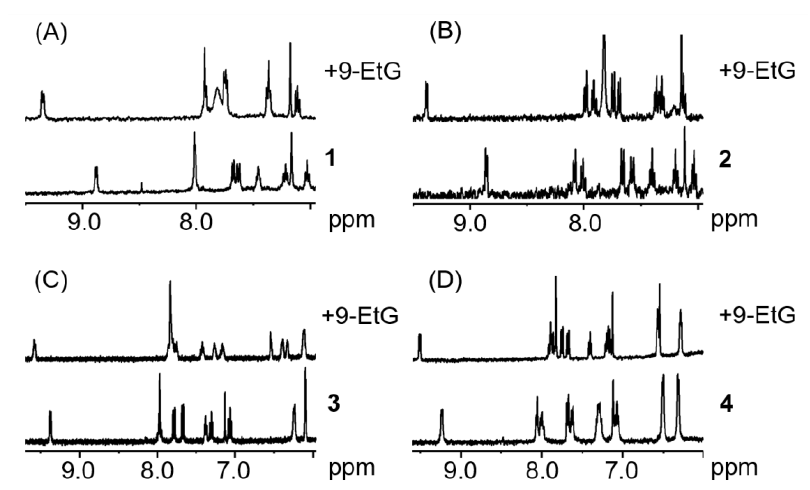
Figure 6. 1 H-NMR spectra of complexes 1 – 4 ( A – D , respectively) in the presence of two mol. equiv. of 9-EtG after less than 10 min (1.1 mM complex, MeOD / D 2 O 1:1 v / v , pH 7.4, 298 K).